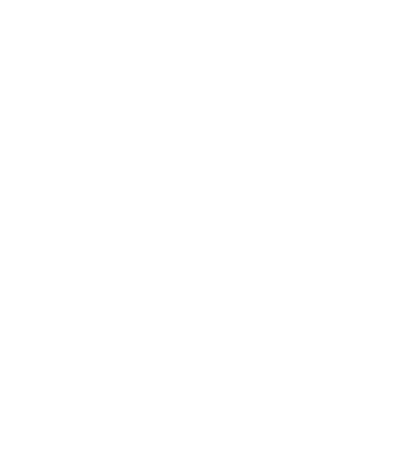
Table 3. Characterization indices for tomato juice